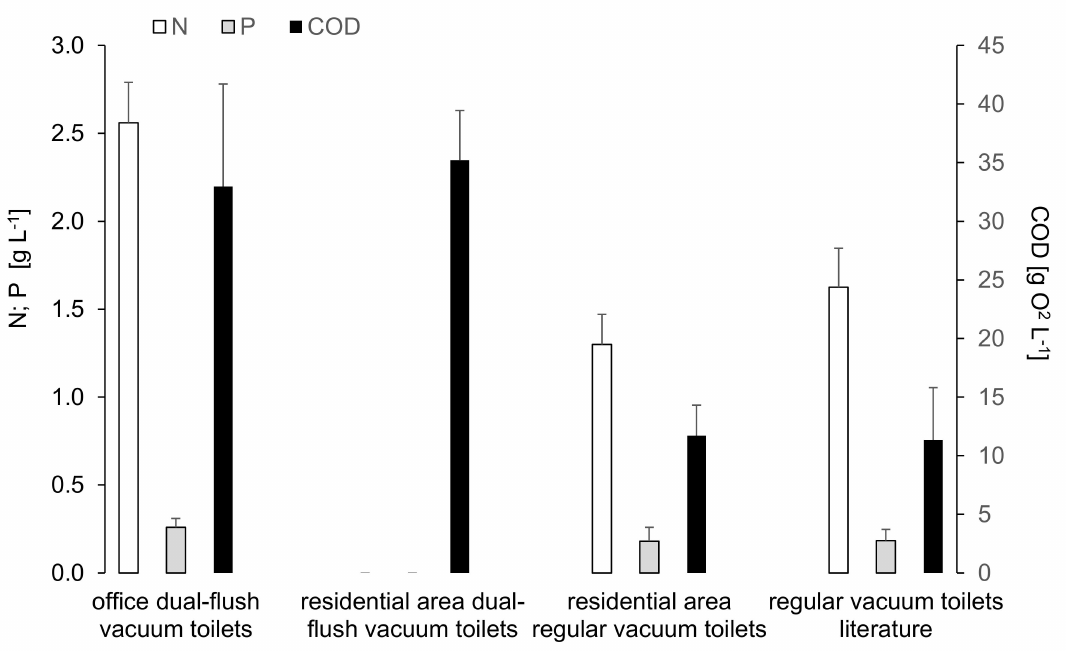
Figure 6. Average concentration range of organic matter and main nutrients in blackwater from the two demo sites with installed dual-flush vacuum toilets compared to blackwater from the former regular vacuum toilets at the residential area and blackwater data from other projects using vacuum toilets in Norway, The Netherlands, and Germany [2]. Error bars are showing the standard